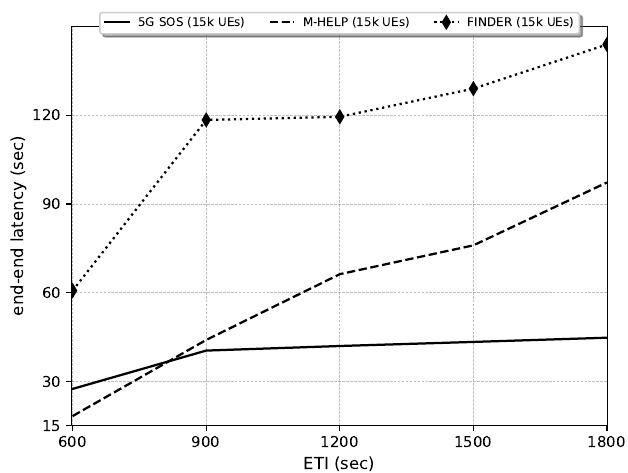
Figure 9. Comparison of end–end latency against ETI under 5G-SOS, M-HELP, and FINDER. Param- eters: ETI: 600–1800 s, NoU: 15,000, NEC: